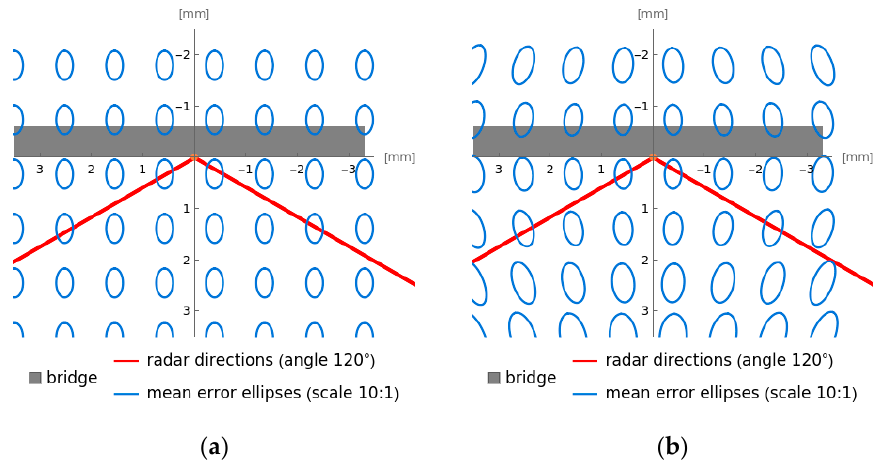
Figure 5. Accuracy of displacement vector [ s X , s Y ] when the radars are located at opposite ends of the bridge and vertical angles of radar directions are 30 ◦ and 150 ◦ : Standard deviation of measured LOS displacements is 0.02 mm. Scale of the mean error ellipses is 10:1. ( a ) Imprecision of the vertical angles of radar directions was neglected; ( b ) precision of the vertical angles is given by means of standard deviation 0.5 ◦